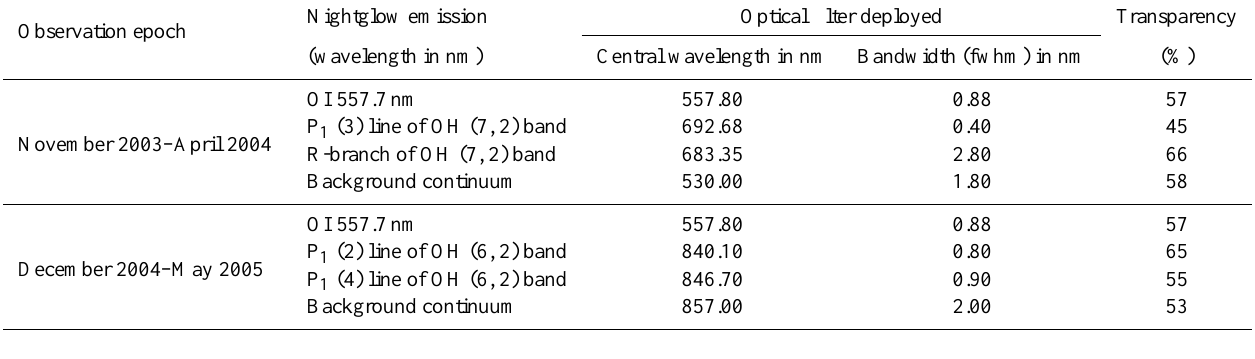
Table 1. Characteristics of the optical filters used for the nightglow observations at Kolhapur during November 2003 to April 2004 and